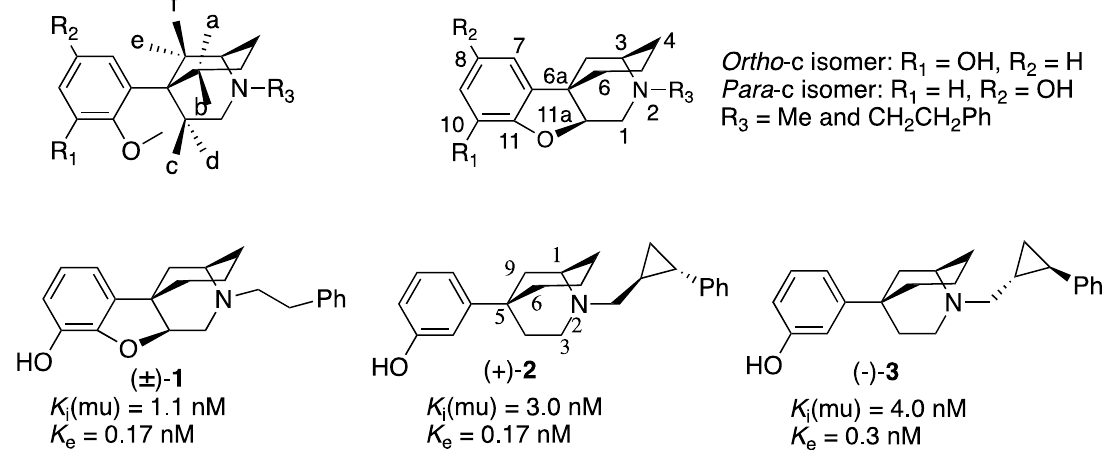
Figure 1. Structures of N -substituted ortho- and para-a through f oxide-bridged phenylmorphans and selected ortho-c oxide-bridged phenylmorphan and 5-phenylmorphan ligands.